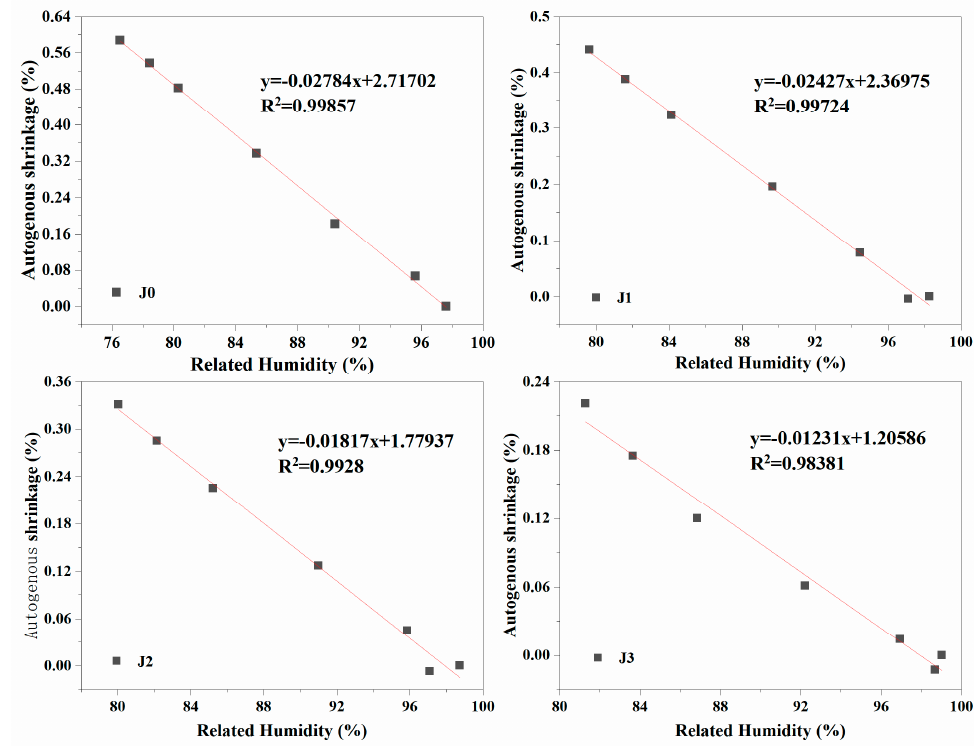
Figure 7. Relationship between RH and autogenous shrinkage of M-S-H mortar.